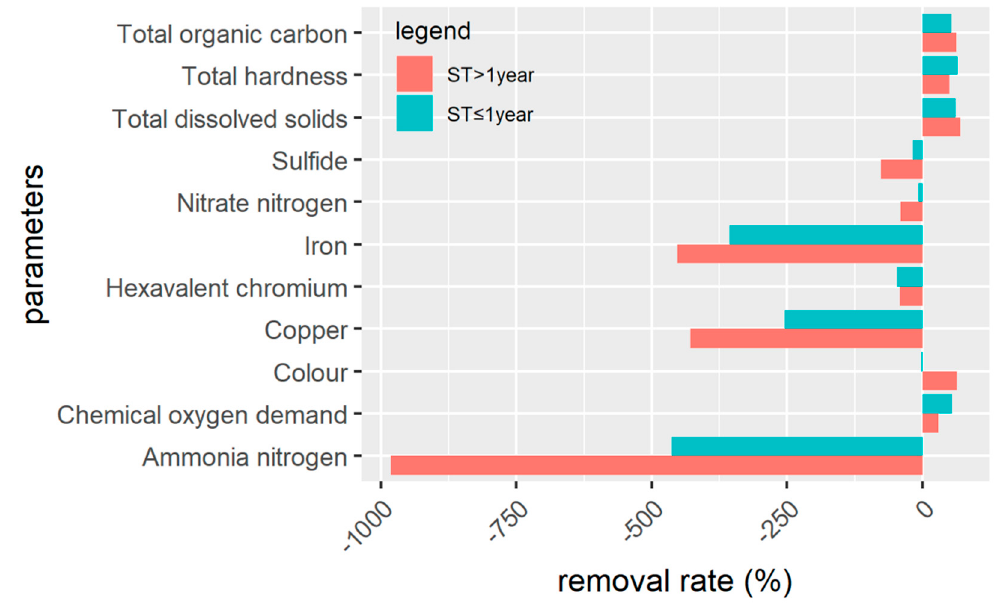
Figure 6. Average removal rate of various pollutants by water treatment systems according to the filter element service time (ST).